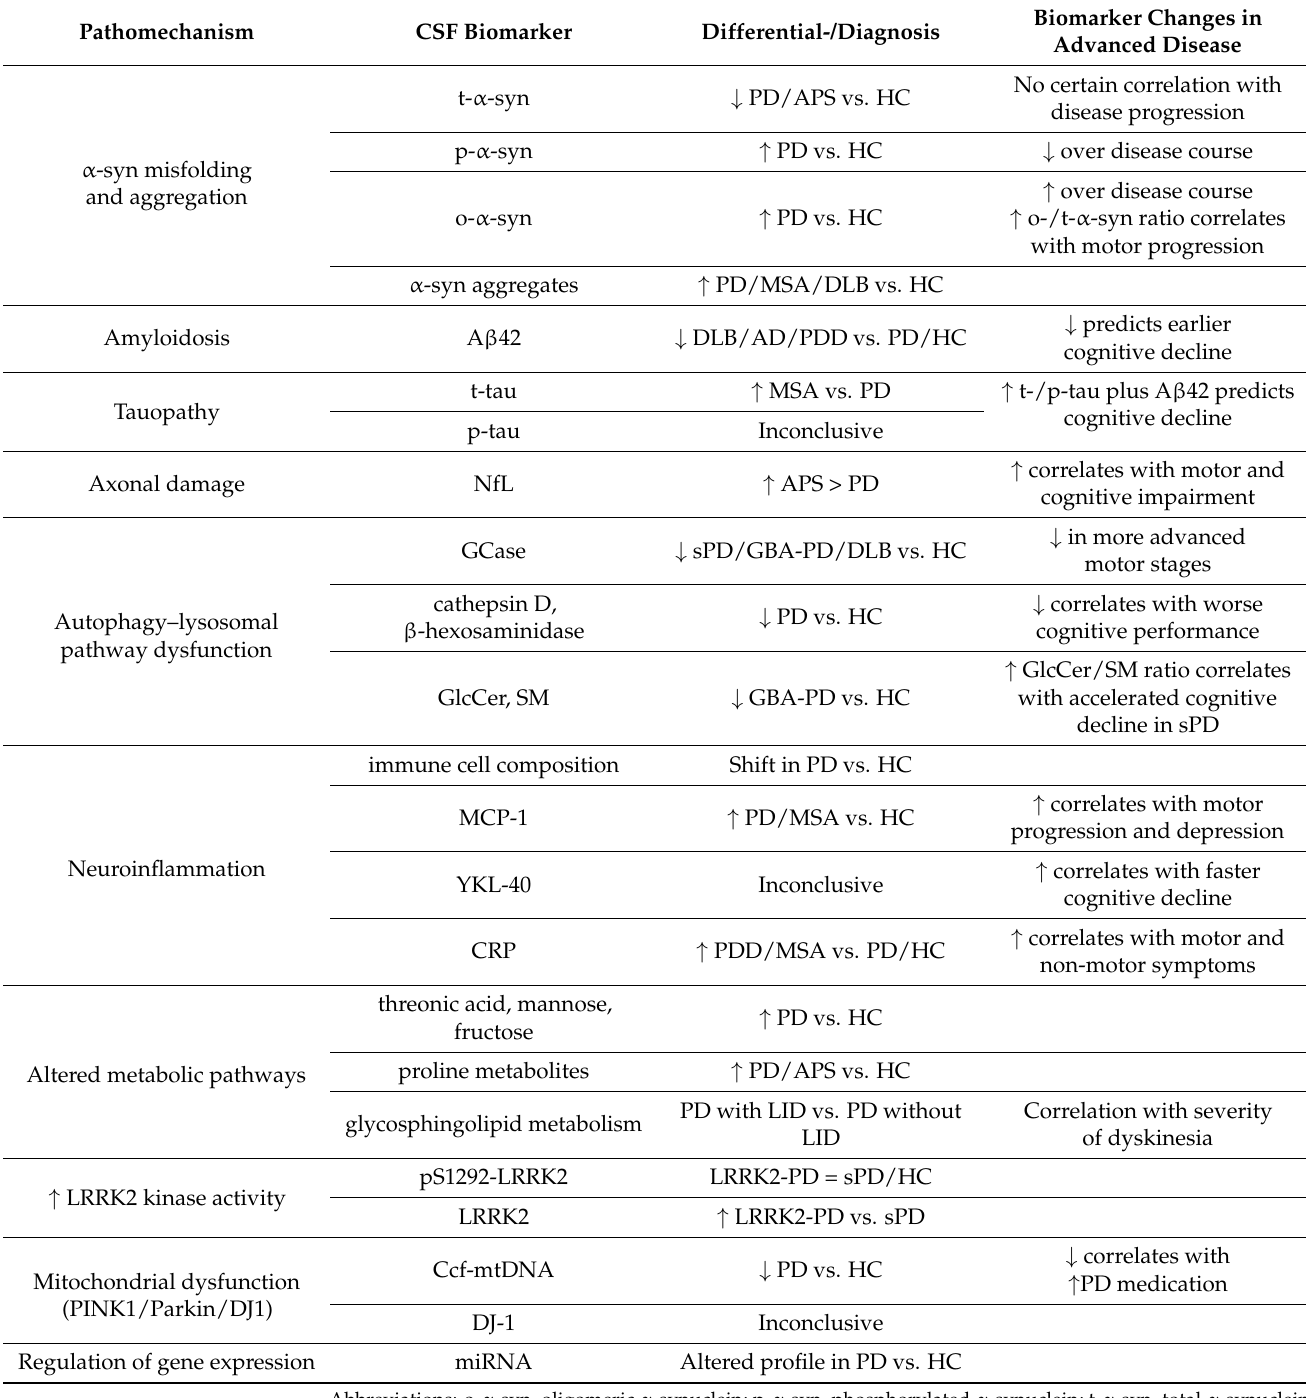
Table 1. Overview of CSF biomarkers according to key pathologic mechanisms involved in PD with diagnostic and prognostic relevance indicating disease severity and